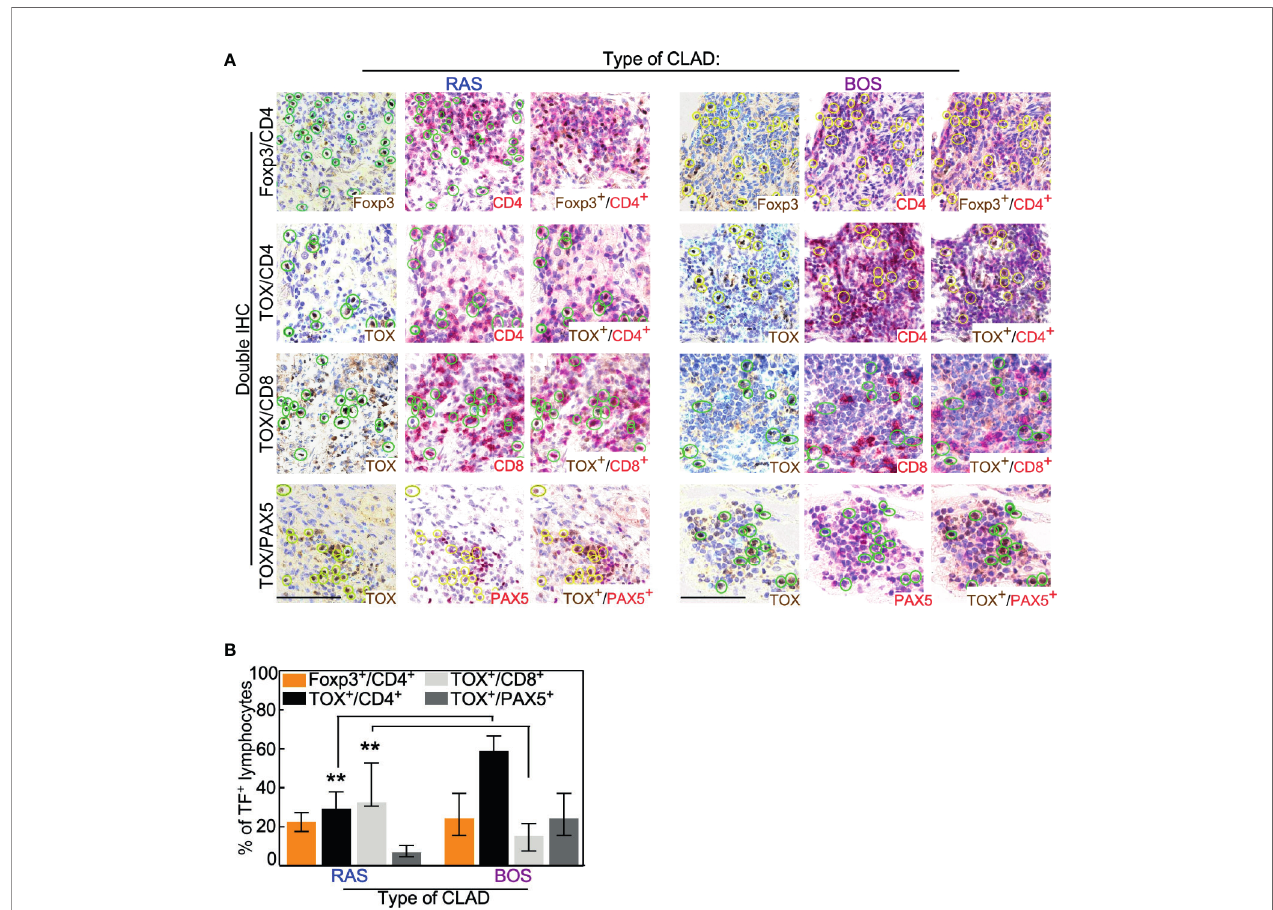
FIGURE 2 | Co-expression analysis of lymphocytic lineage markers. (A) Double IHC was performed with the lineage-speci fi c transcription factor (TF) Foxp3 or TOX and the membrane antigens CD4, CD8, or Pax5. Representative images of the indicated staining are shown for RAS and BOS lung explants. Scale bars, 100 m m. See also Supplementary Figure 1 . (B) The percentage of lymphocytes positive for the indicated membrane antigen was calculated from the total number of cells expressing Foxp3 or TOX. Bars represent median ± IQR. **p = 0.008 by two-sided Mann-Whitney U